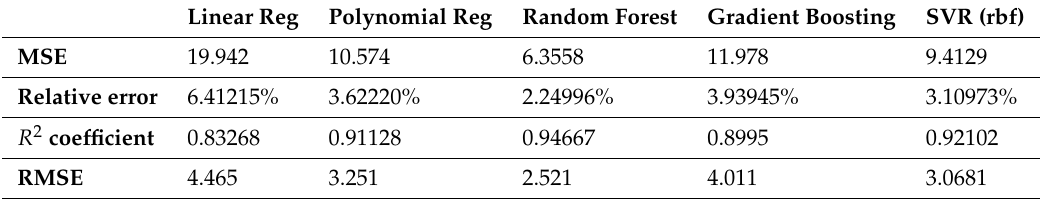
Table 5. Second experiment: evaluation coefficients for linear regression, polynomial regression, random forest, gradient boosting and Support Vector Machine with rbf